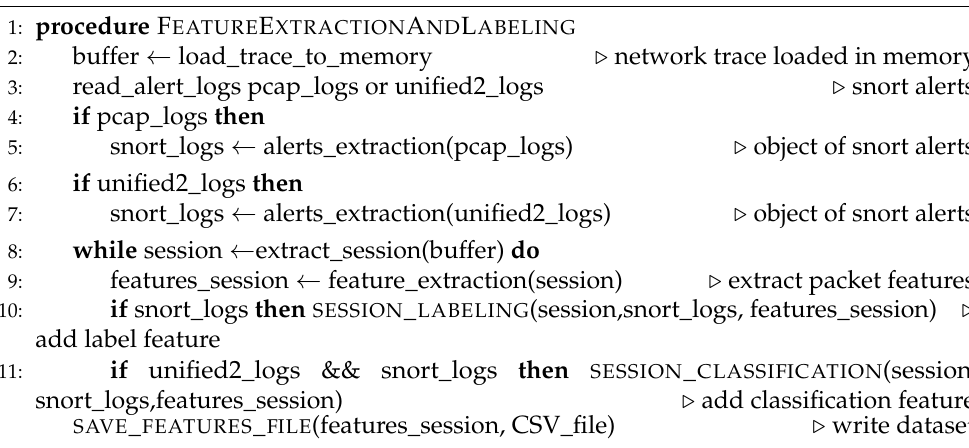
Algorithm 3 Feature extraction and labeling from network